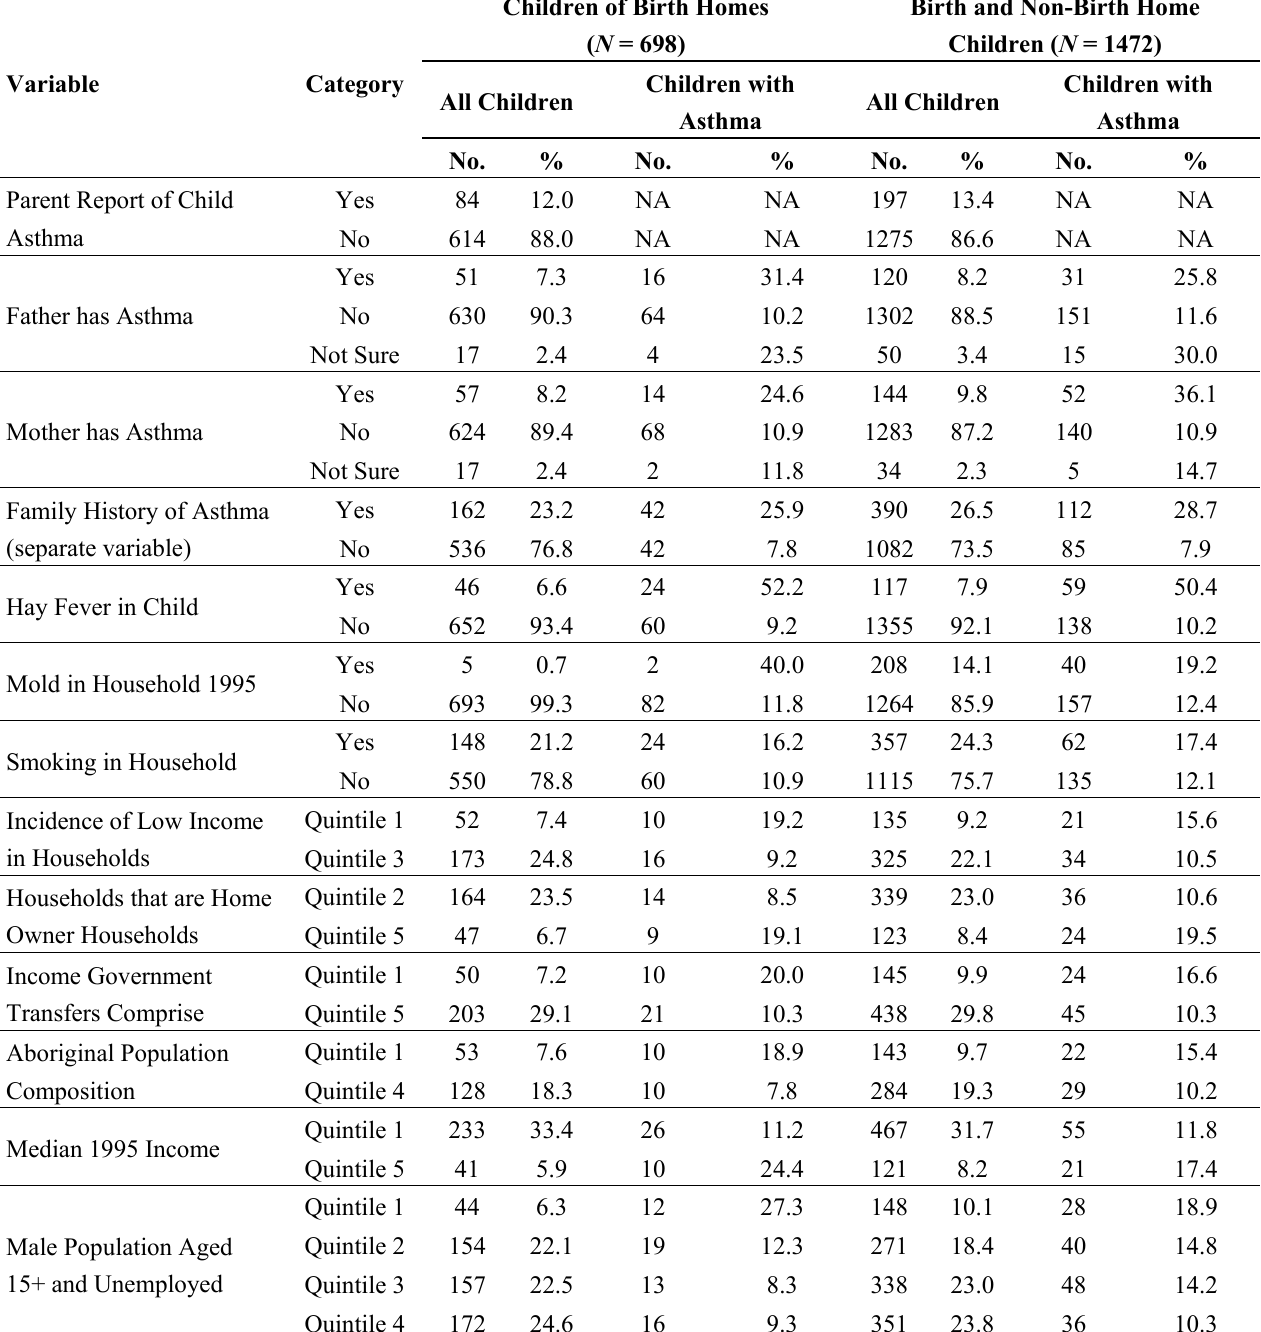
Table 1. Characteristics of Winnipeg Schoolchildren in the Study